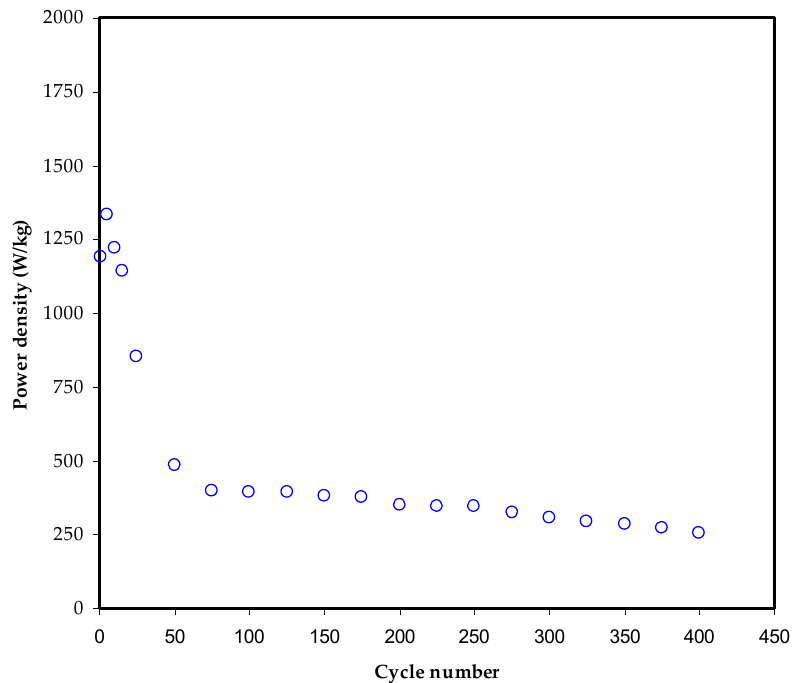
Figure 13. Power density ( P d ) for the assembled EDLC throughout 400 cycles.